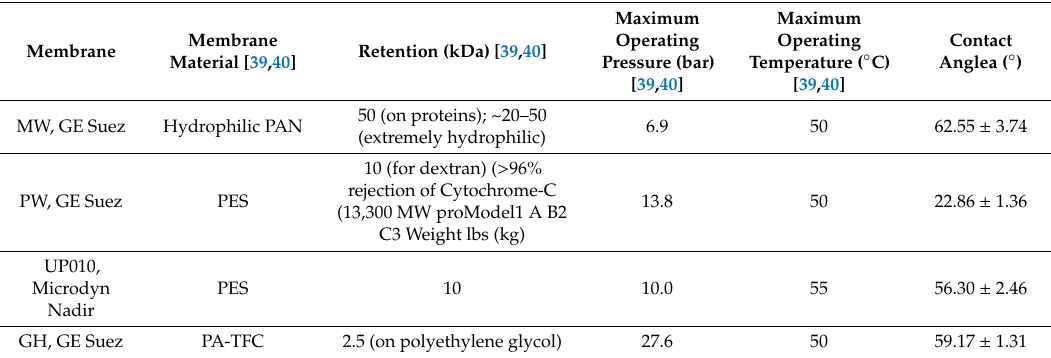
Table 2. Properties of the membranes analyzed (according to the manufacturers’